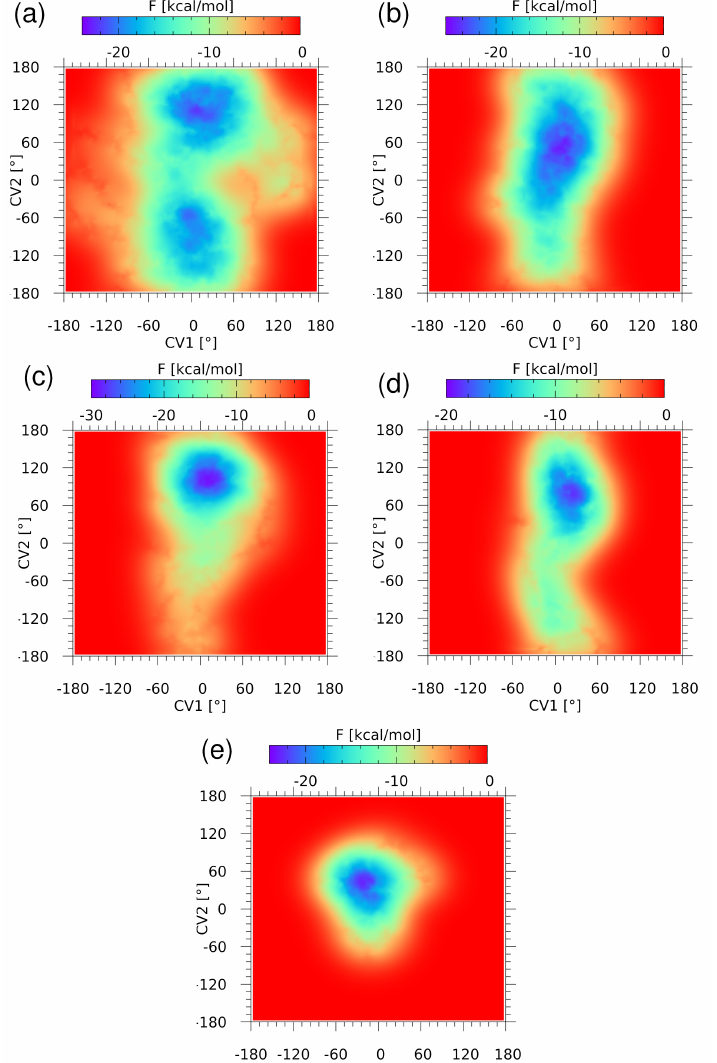
Figure 4. Free energy (F) surface reconstructed from the metadynamics run for ( a ) the AZM molecule, ( b ) the AZM-T, ( c ) the AZM-TT, ( d ) the AZM-TTL, and ( e ) the AZM-TTLH. The collective variables are the following dihedral angles: CV1 is the S1-C2-N4-C1 dihedral, and CV2 is the S1-C3-S2-O2B dihedral (see Figure 2 for atoms numbering